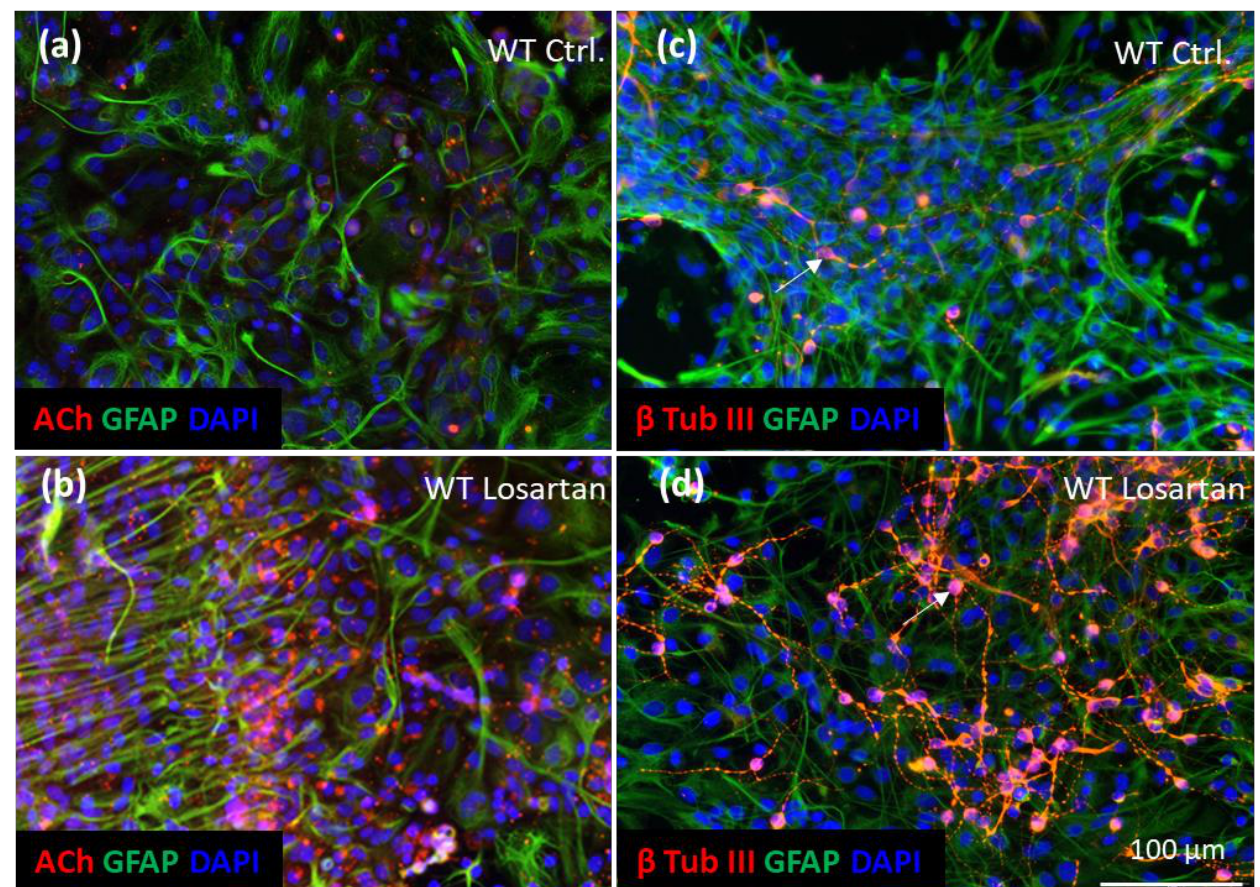
Figure 6. Losartan-induced neurogenesis and ACh production in wild type (WT) astroglial primary cultures (APC). ( a , b ) Immunofluorescent analysis of GFAP (green) and ACh (red) in losartan vs. vehicle (Ctrl.) treated WT APC. ( c , d ) Expression of β tubulin III (red) and GFAP (green) in losartan/vehicle treated WT APC. Arrow in ( d ) indicates young β tubulin III positive neuron in losartan treated culture. Cell nuclei are stained with DAPI (blue), scale bar in ( d ) corresponds to the images shown in ( a – d ). ( a – d ) Representative images out of n = 4 cover slips stained with ACh/GFAP or β tubulin III/GFAP in each treatment condition.